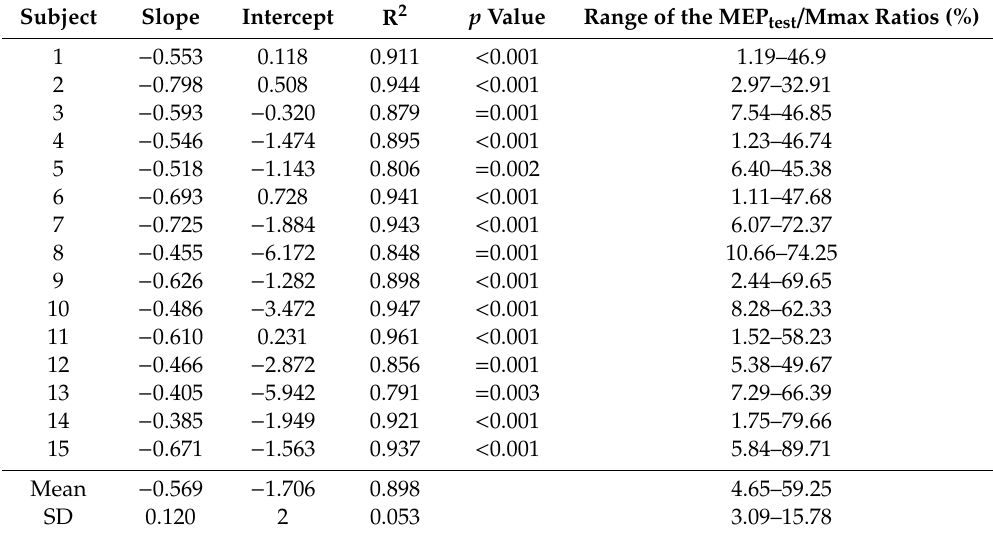
Table 2. Regression analysis between MEP test /Mmax ratio (independent variable) and SICI Mmax (dependent variable) estimated individually for each subject. Individual slopes, intercept, R 2 , p values and range of the MEP/Mmax ratios were extracted and reported.